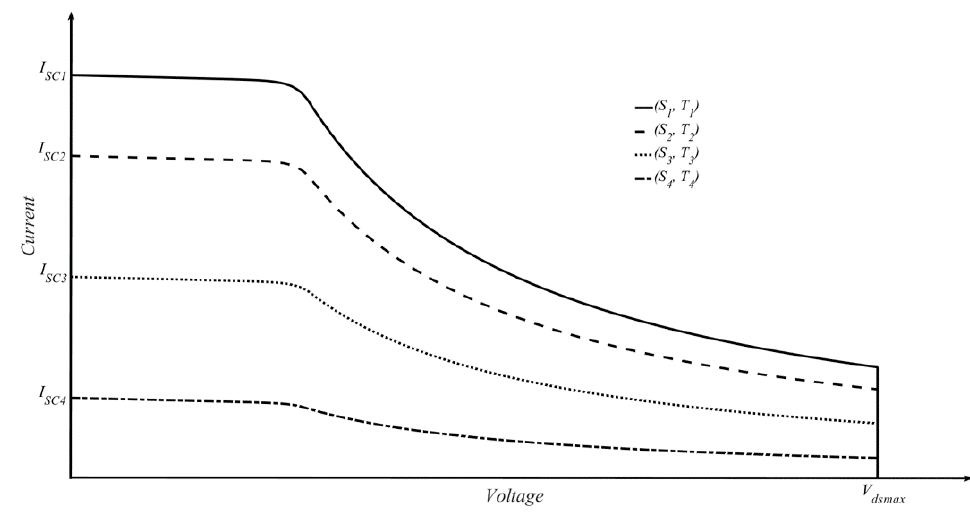
Figure 7. I-V characteristics of Boost-based PVU.